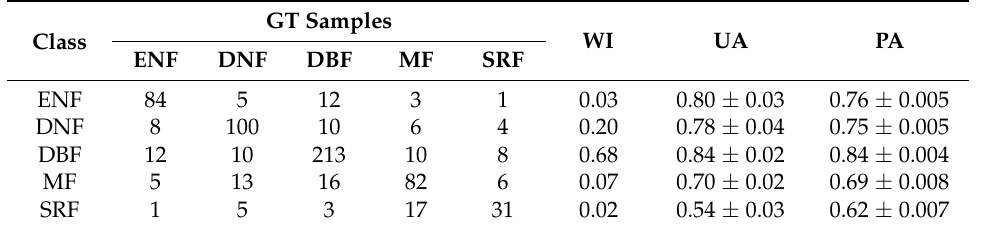
Table 5. Confusion matrix of the forest subcategories from HJ-1-based map with a 95% confidence